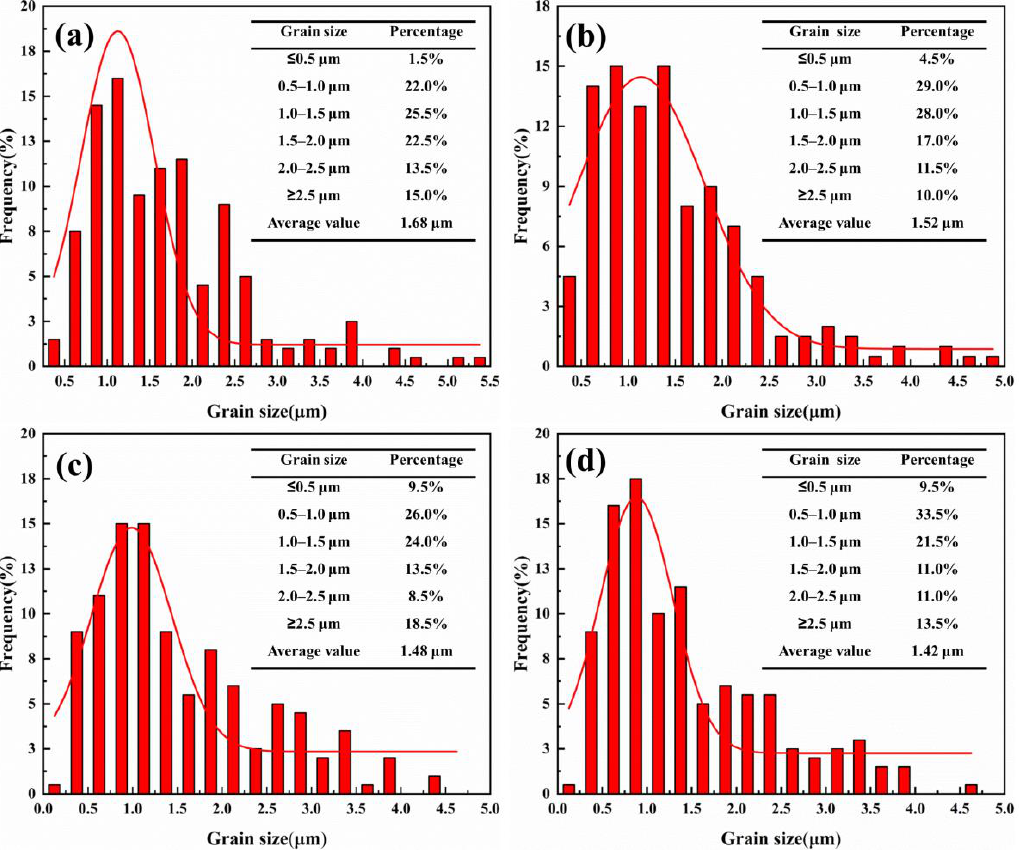
Figure 11. Grain size distribution of the cermets with different ratios of SiC p to SiC w : ( a ) 0.0SiC p 2.0SiC w ; ( b ) 0.5SiC p 1.5SiC w ; ( c ) 1.0SiC p 1.0SiC w ; ( d ) 1.5SiC p 0.5SiC w .